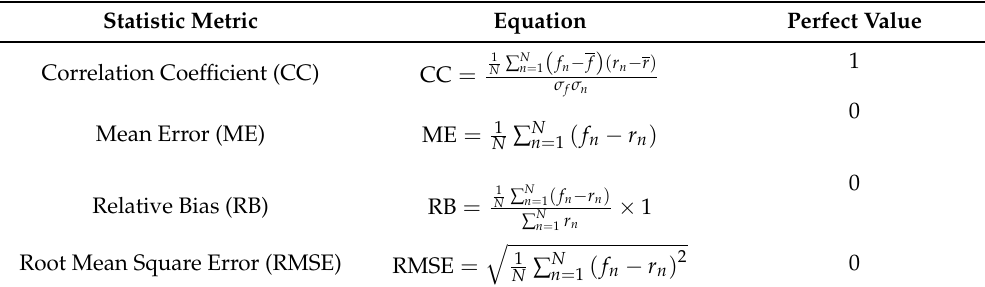
Table 2. List of the statistical metrics used in the statistical